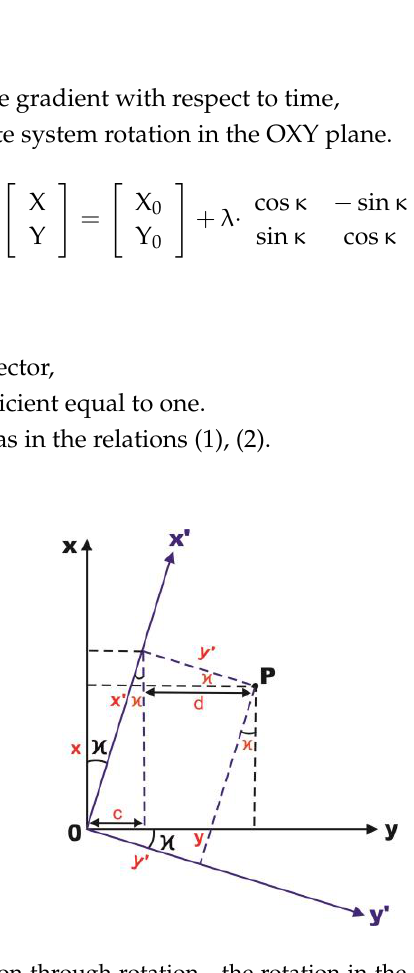
Figure 1. The transformation through rotation — the rotation in the oxy plane at κ angle — rotation around the z axis (yaw angle).